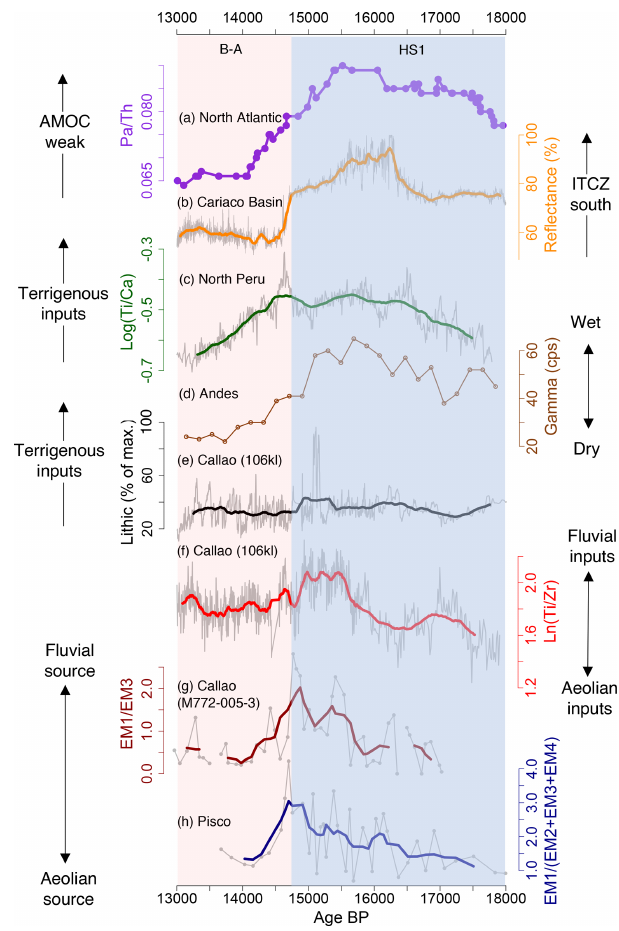
Figure 7. (a) Composite 231 Pa / 230 Th record that reflects past changes in the AMOC (Ng et al., 2018). (b) Reflectance (%) from the Cariaco Basin as a proxy for the latitudinal displacement of the ITCZ (Deplazes et al., 2013). (c) Log (Ti / Ca) for core M77/2-059 from northern Peru (4 ◦ S; Mollier-Vogel et al., 2003). (d) Natural γ radiation as a proxy for effective moisture in the tropical Andes (Baker et al., 2021b). (e) Relative concentration of lithics for core 106 KL from Callao (Rein et al., 2005). (f) Ln (Ti / Zr) as a proxy for fluvial vs. eolian inputs in core 106 KL from Callao (this study). (g) EM1 / EM2 ratio as a proxy for fluvial and eolian sources in Callao (this study). (h) EM1 / (EM2 + EM3 + EM4) ratio as a proxy for fluvial and eolian sources in Pisco (this